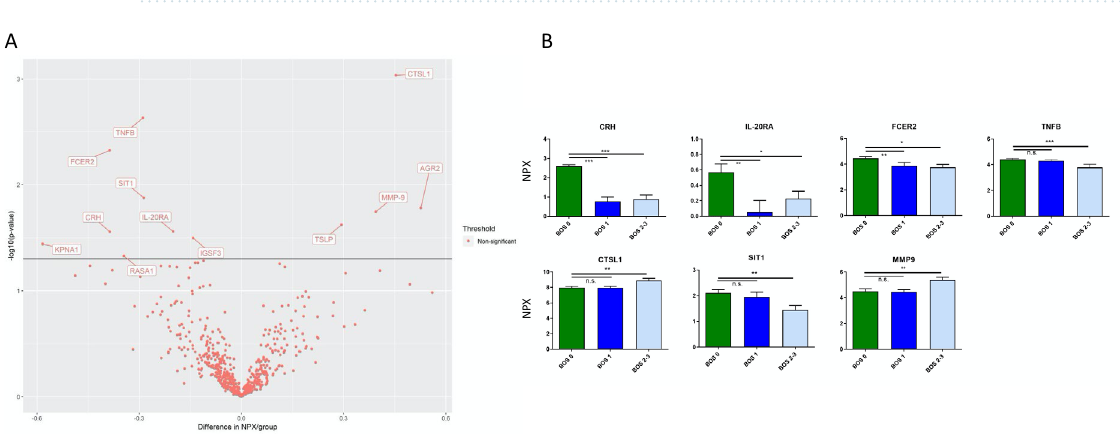
Figure 3. Comparison of BOS Grades 1 and 2–3 with Biomarker Candidates. Patient samples were subdivided between BOS grade 1 and grade 2–3 and then compared to BOS grade 0. Readouts are reported as normalized protein expression levels (NPX) relative to controls. ( A ) shows a volcano plot of the 644 proteins anlysed using Olink proteomics. A linear regression model was conducted with the solid line depicting a p-value = 0.05. The named proteins in the plot have a p-value < 0.05. Proteins on the positive x-axis have higher NPX values in the BOS grade 2–3 group, and proteins on the negative x-axis have higher NPX values in the BOS grade 0 group. ( B ) shows mean and SEM of seven of the most significant proteins. * p < 0.05, ** p < 0.01, *** p < 0.001. CRH, corticotropin releasing hormone; IL-20RA, Interleukin-20 receptor subunit alpha; FCER2, low